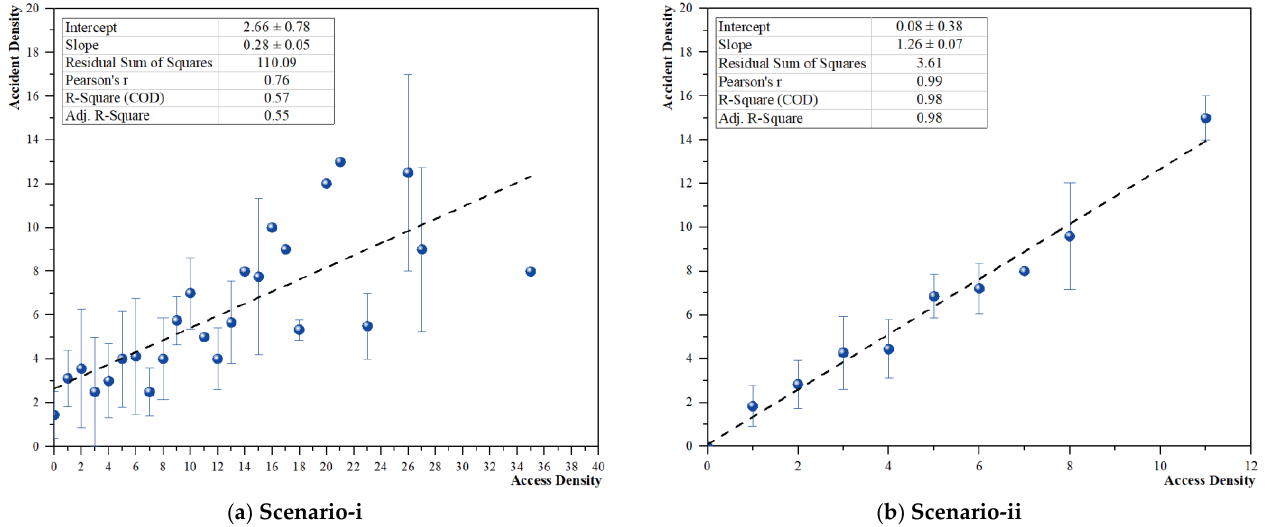
Figure 6. Access Density vs. Accident Density for both the investigated scenarios.